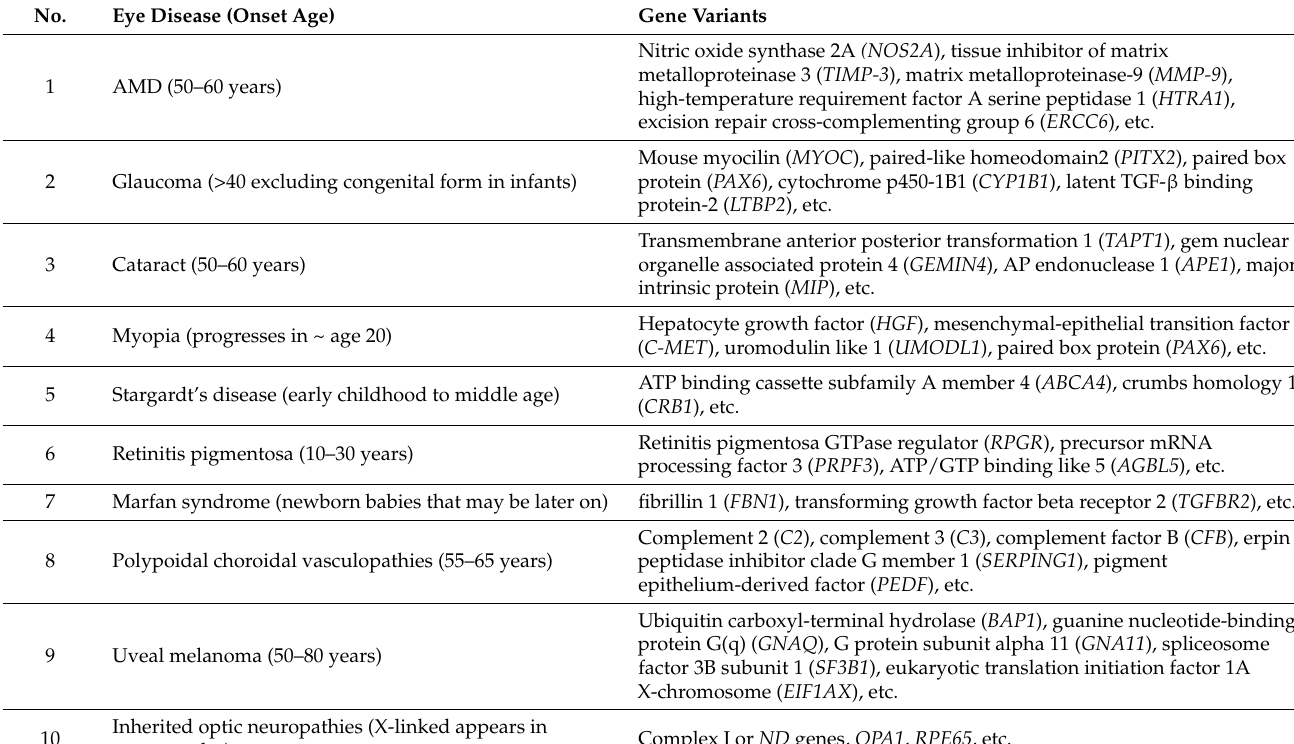
Table 1. Gene variants associated with common human eye